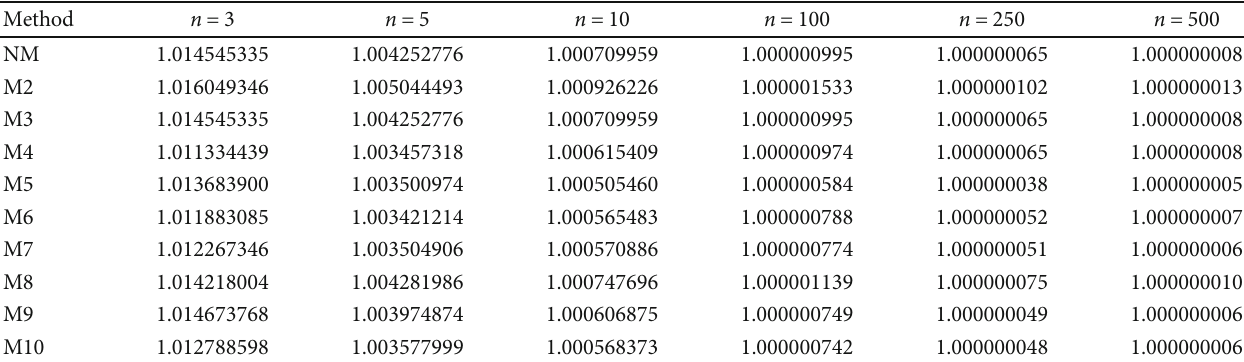
Table 24: The values of FLEI for the methods in the fi rst category to solve Test Problem 1, and n = 3, 5, 10,100,250,500 . Method